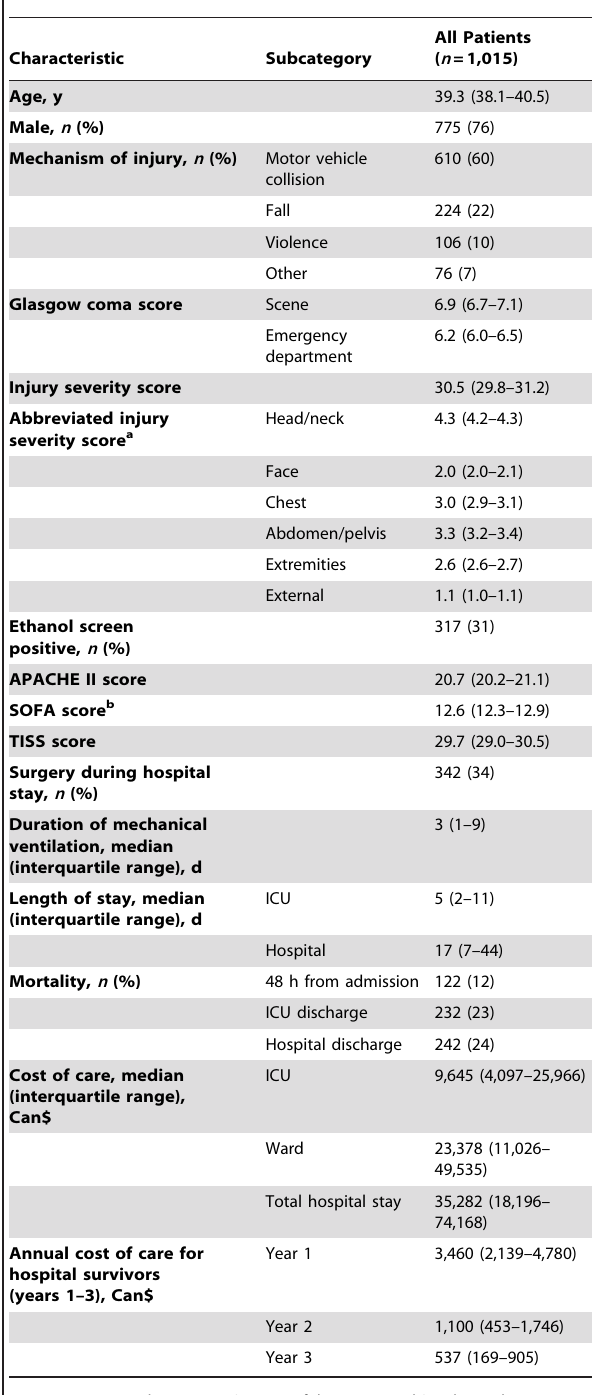
Table 1. Patient characteristics, costs, and outcomes.